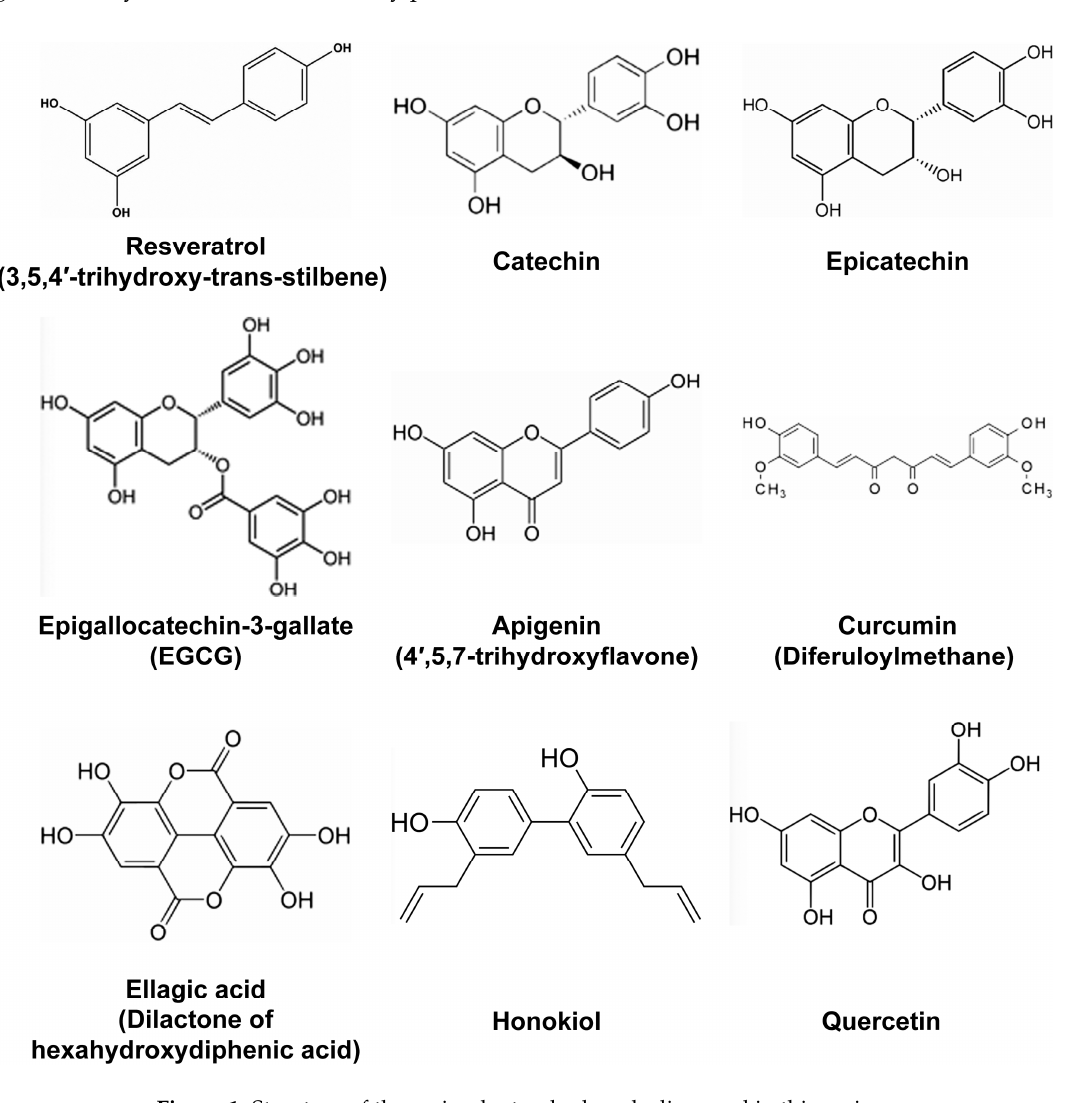
Figure 1. Structure of the main plant polyphenols discussed in this review.